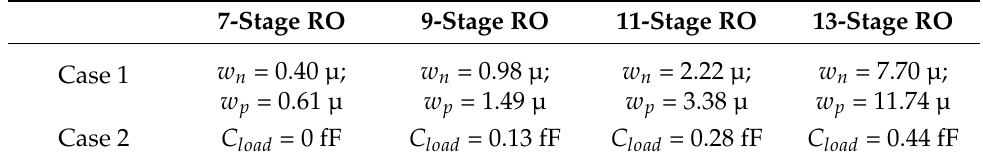
Table 3. Strategies of differentiation